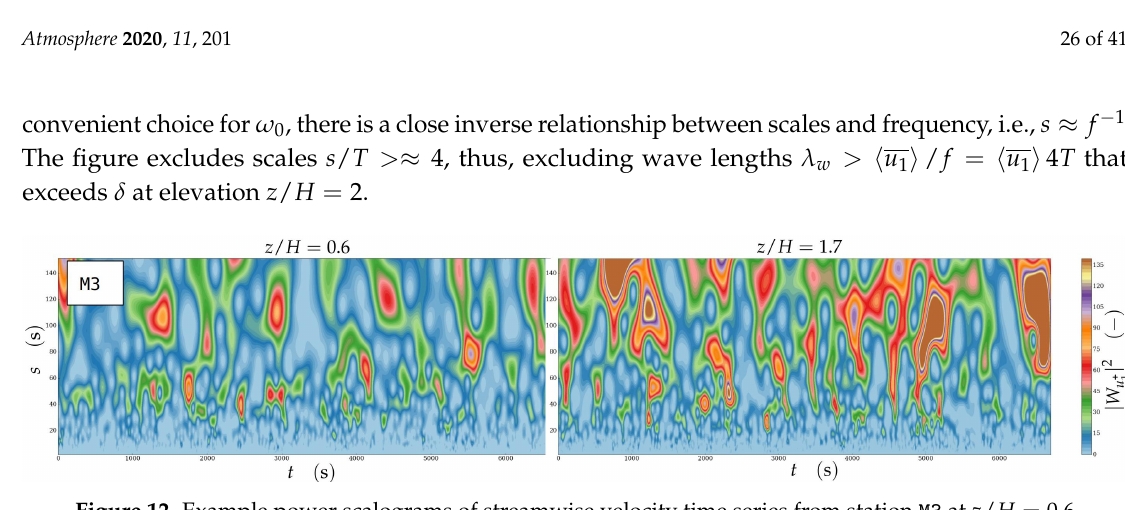
Figure 12. Example power scalograms of streamwise velocity time series from station M3 at z / H = 0.6 ( left ) and z / H = 1.7 ( right ), collected from the reference simulation [R]